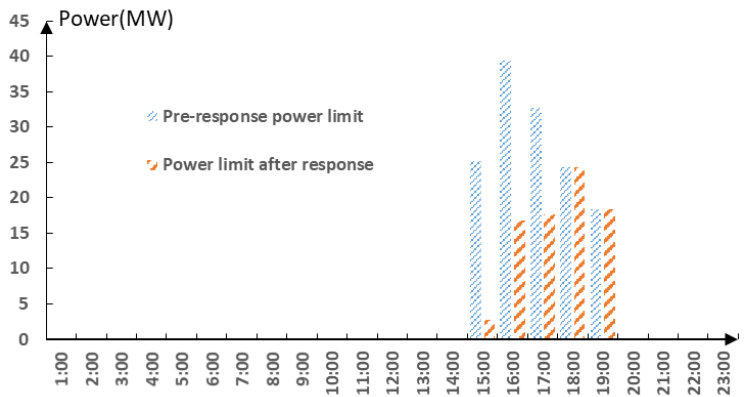
Figure 7. Under-response power limit.